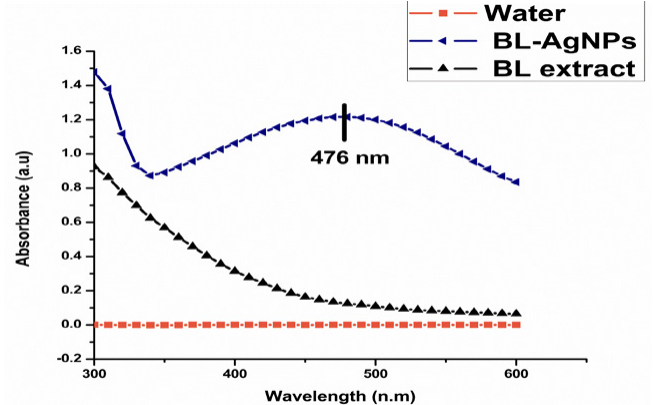
Fig. 7. UV-Visible spectroscopy of water, BL extract and